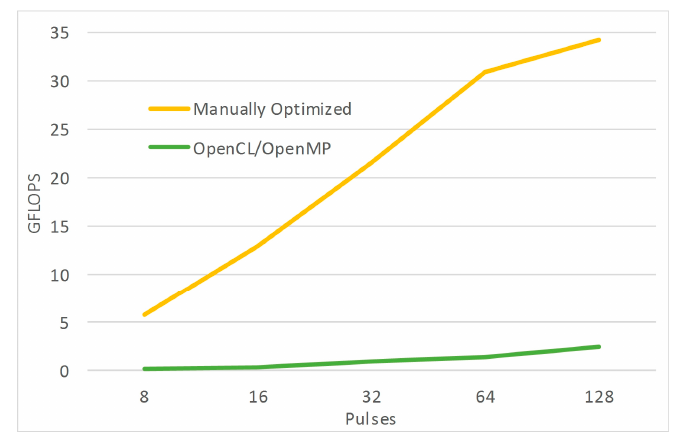
Figure 20. Comparing OpenCL performance to manually optimized code for Doppler processing.